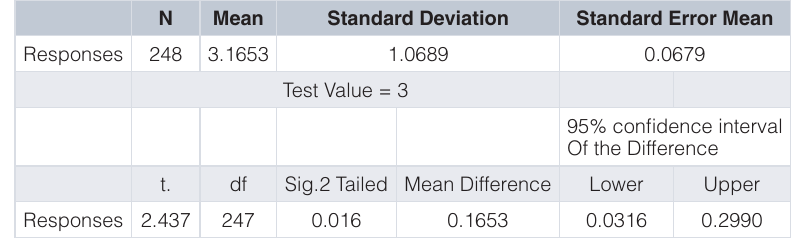
Table 7. Agricultural Extension Services of Edo Agricultural Development Programme (ADP) and Farm